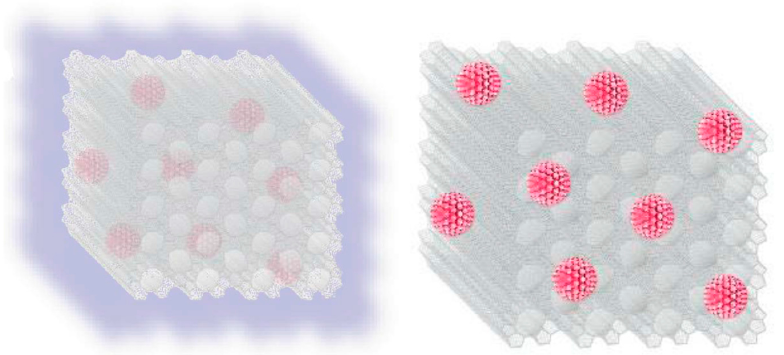
Figure 10. Models of the AuPd@ZSM ‐ 5 ‐ R (left) and AuPd/ZSM ‐ 5 (right) catalysts AuPd@Zeolite ‐ R, where the @ symbol denotes encapsulation of the nanoparticles within the zeolite and R indicates the organic substituent of the silane sheath; A conventional ZSM ‐ 5 zeolite–supported AuPd nanoparticle catalyst was prepared by impregnating with the same loading, denoted as AuPd/ZSM ‐ 5. Reproduced with permission from [29]. Copyright 2020 American Association for the advancement of science.